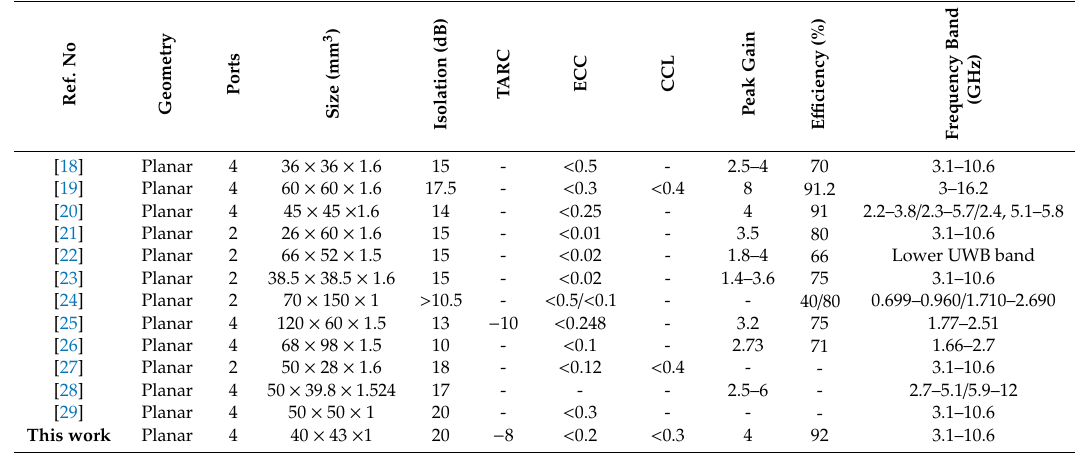
Table 1. Comparison with the existing